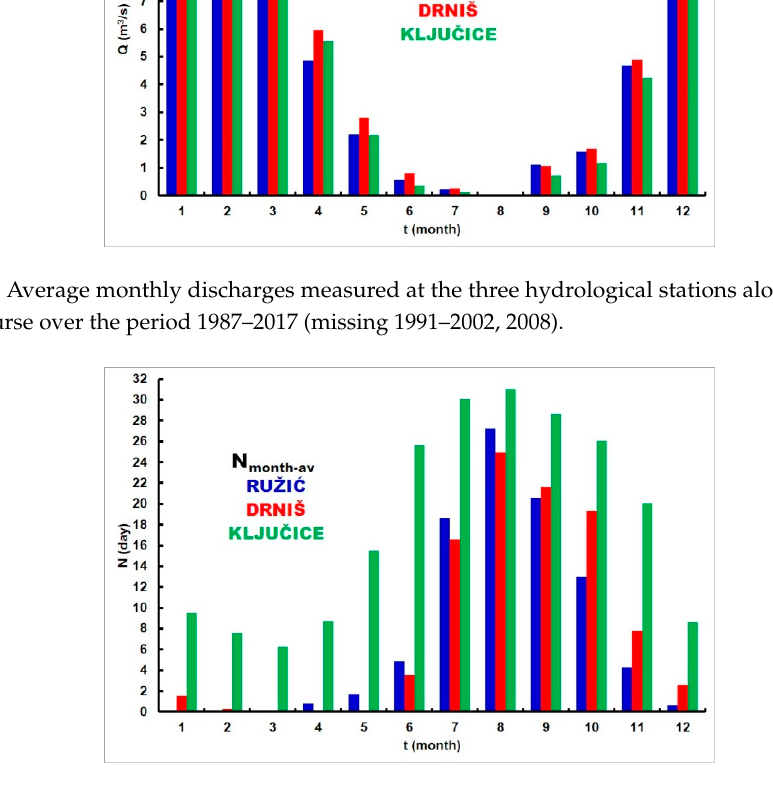
Figure 8. Average dry days, N, in the months monitored at the three hydrological stations along the Č ikola River course over the period 1987–2017 (missing 1991–2002, 2008).